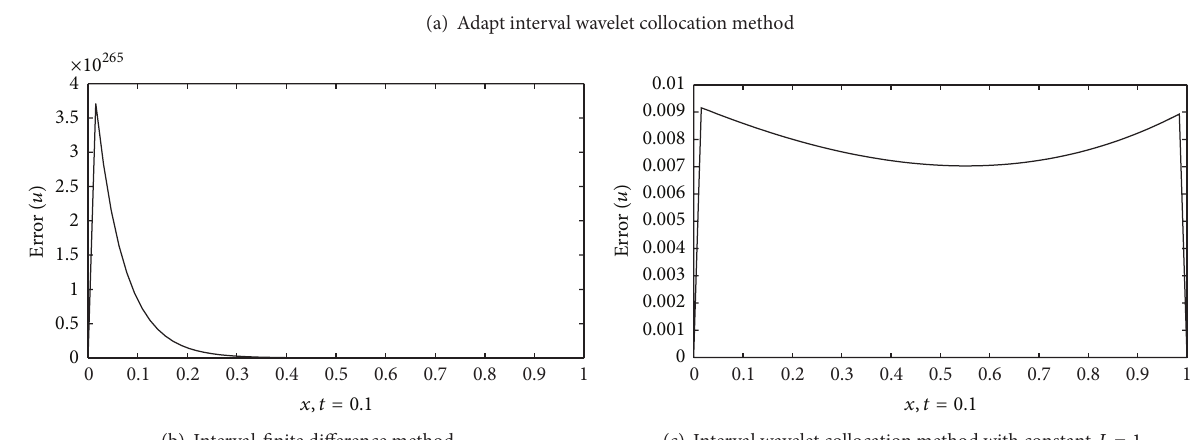
Figure 3: Numerical errors comparison among the dynamic, static interval wavelet method and the finite difference method ( 𝑗 = 6,𝛼 = 0.6 ).